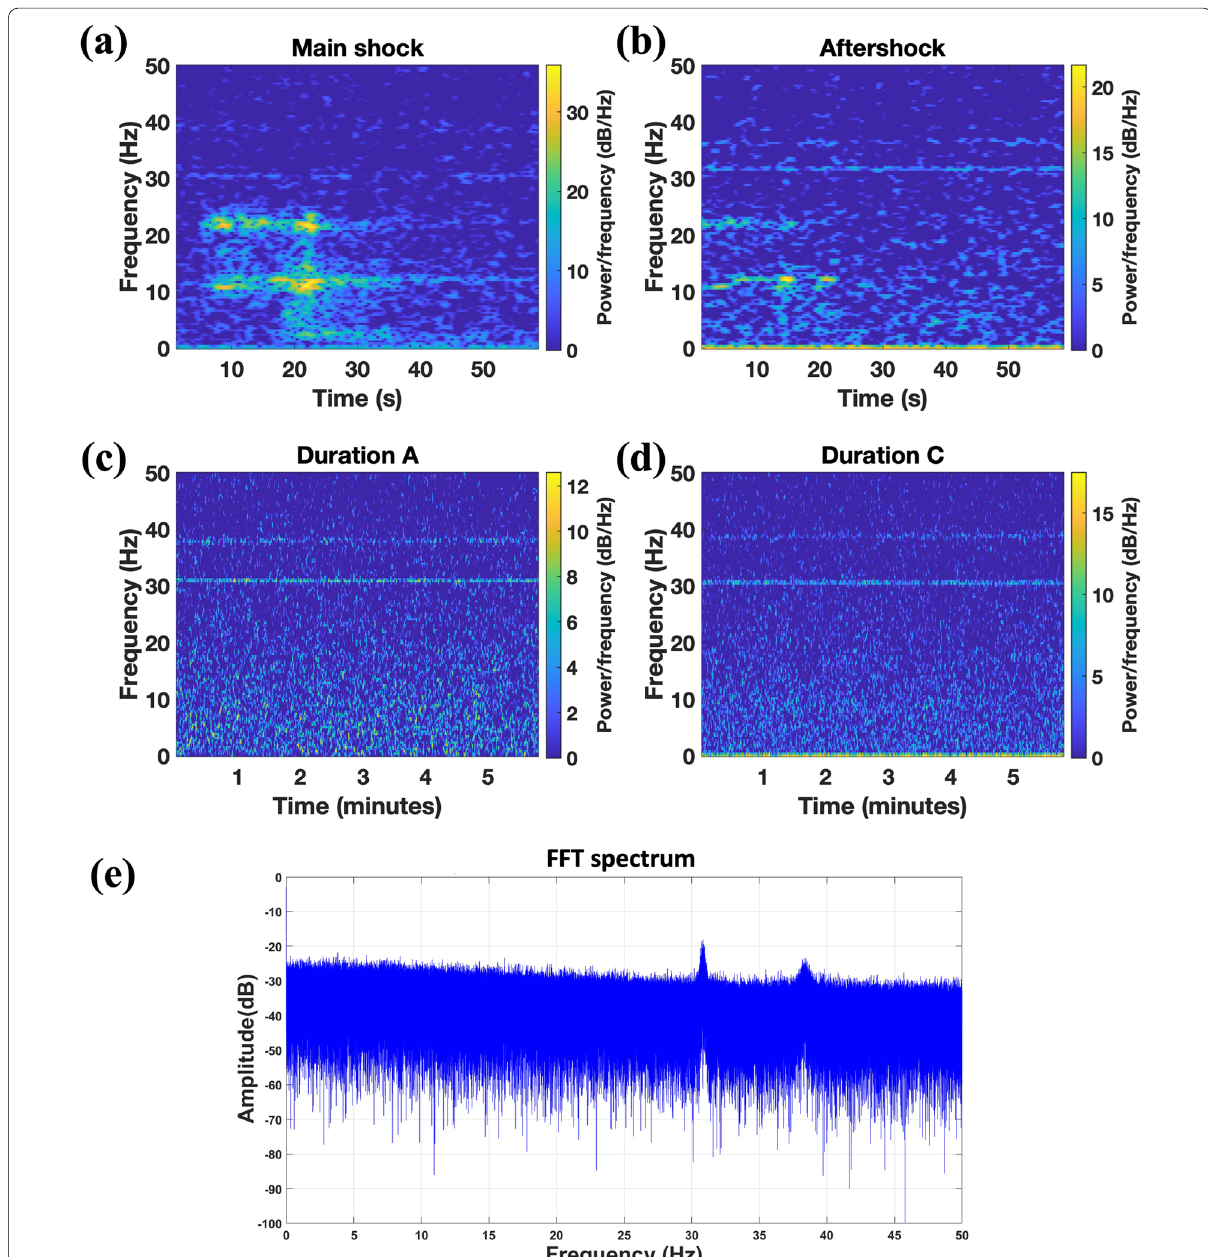
Fig. 7 Time‑dependent frequency distributions obtained from the STFT analysis made in the time periods of the a main shock, b aftershock, c duration A, and d duration C. e FFT spectrum obtained from signals recorded by our FOG operating at a 100‑Hz data rate over a period of